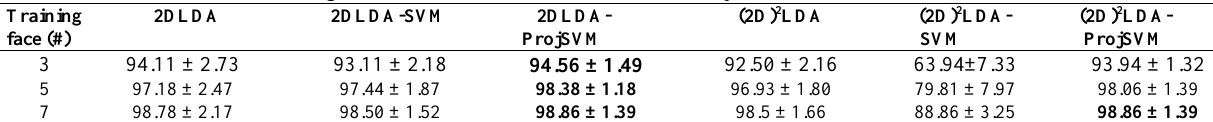
Table 6. Mean classification accuracy (in percent) over 10 random runs for JAFFE dataset with reduced dimension of 10 using 2DLDA and (2D) 2 LDA as dimensionality reduction methods.